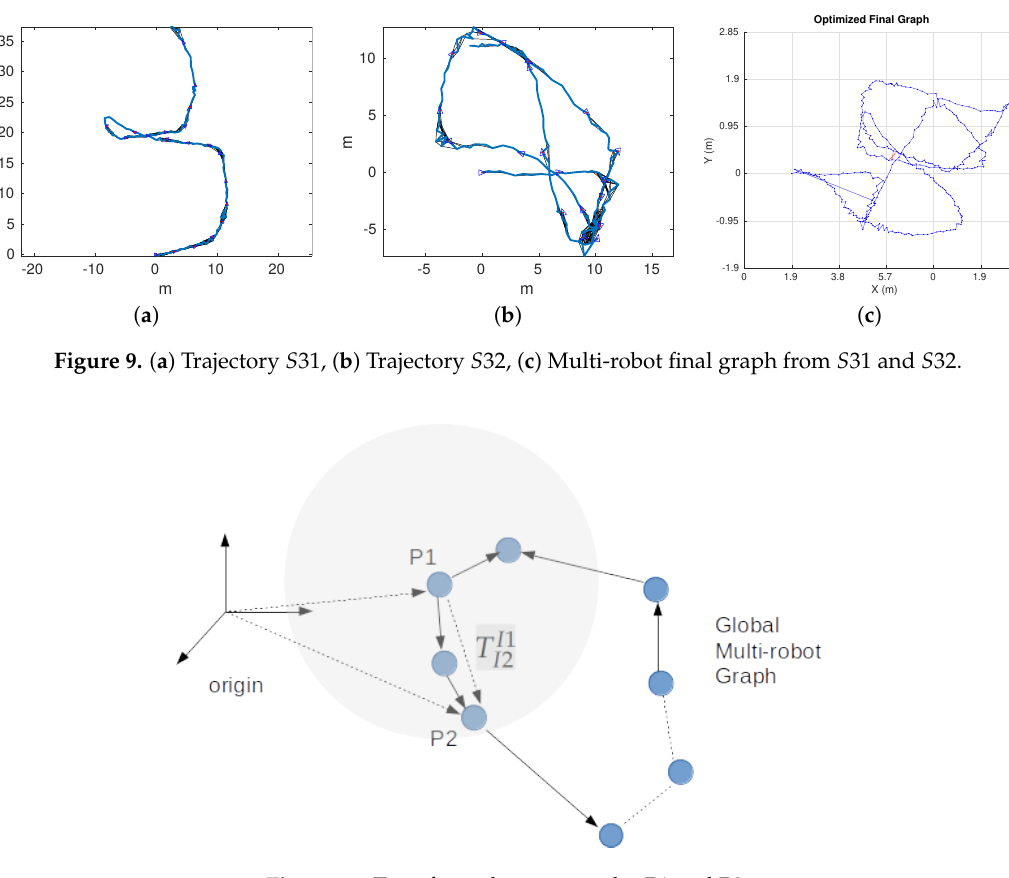
Figure 10. Transforms between nodes P1 and